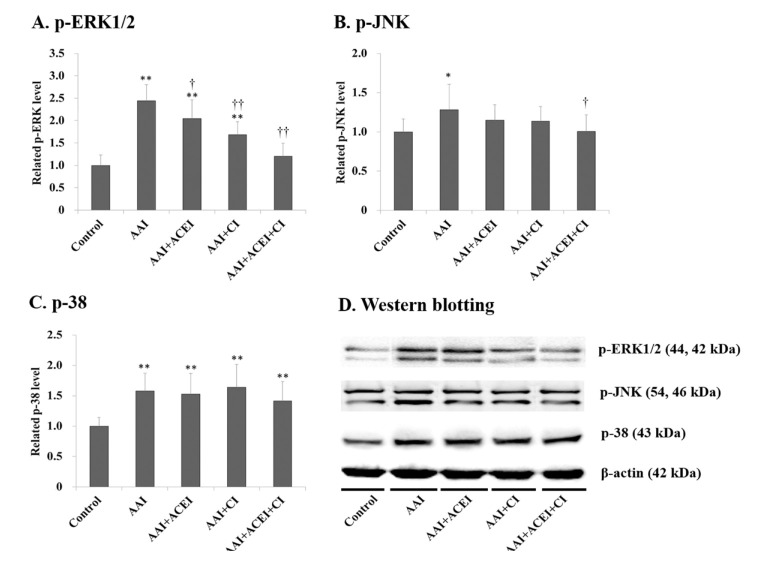
The MAPK signaling pathways in the kidneys of mice with AAI-induced acute nephropathy.The expression of p-REK1/2 (A), p-JNK (B) and p-38 (C) in kidney tissue was determined using Western blotting, and representative results of Western blotting are shown (D). All values are expressed as the means ± SD from each group (n = 9). * and ** indicate p < 0.05 and p < 0.01 compared to the Control group, respectively; † and †† indicates p < 0.05 and p < 0.01 compared to the AAI group, respectively.